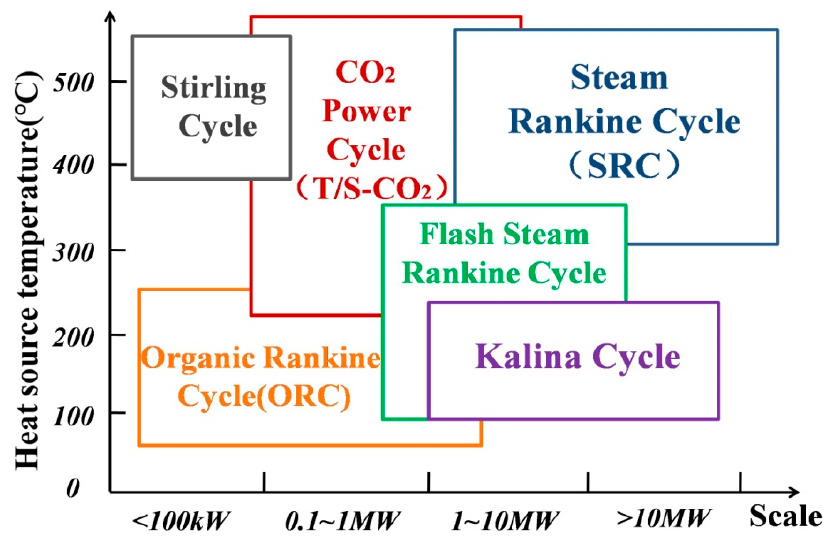
Figure 3. Thermodynamic cycles for waste heat recovery at various temperature-levels and scales.